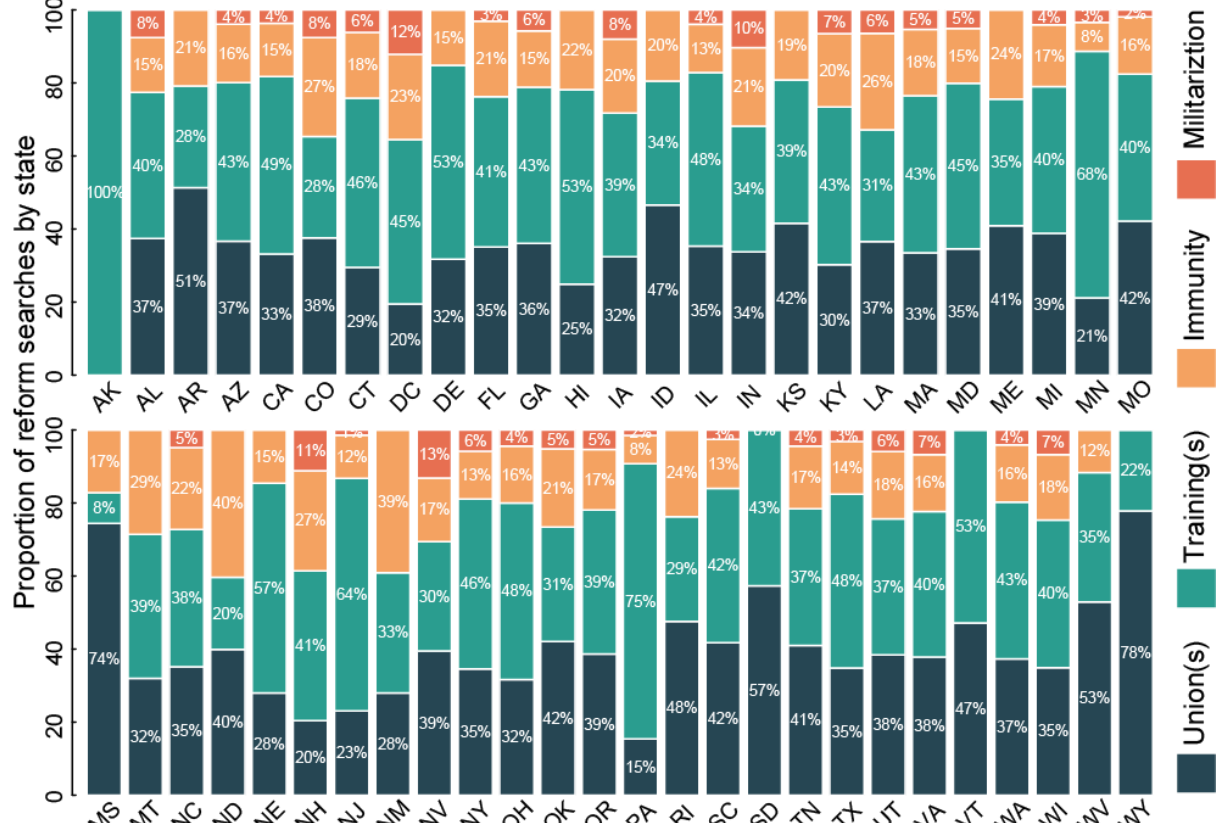
Figure 4. Internet searches for specific police reforms following the death of George Floyd, by US state (including Washington DC). Queries included all searches with the terms “police” and (A) “immunity,” (B) “union(s),” (C) “training,” or (D) “militarization,” normalized to the total volume of searches for all four topics by state following Mr Floyd’s death (May 25, 2020, through July 5, 2020). For instance, 37% for police “union(s)” in Alaska means that 37% of searches for “union(s),” “immunity,” “training,” and “militarization” combined were for “union(s).” States are ordered